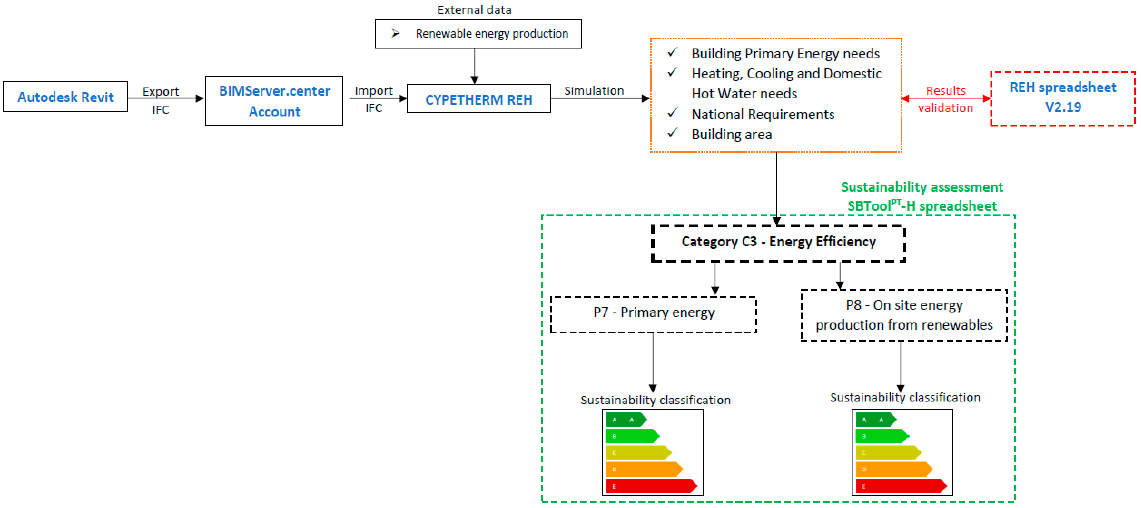
Figure 1. Simulation procedure.